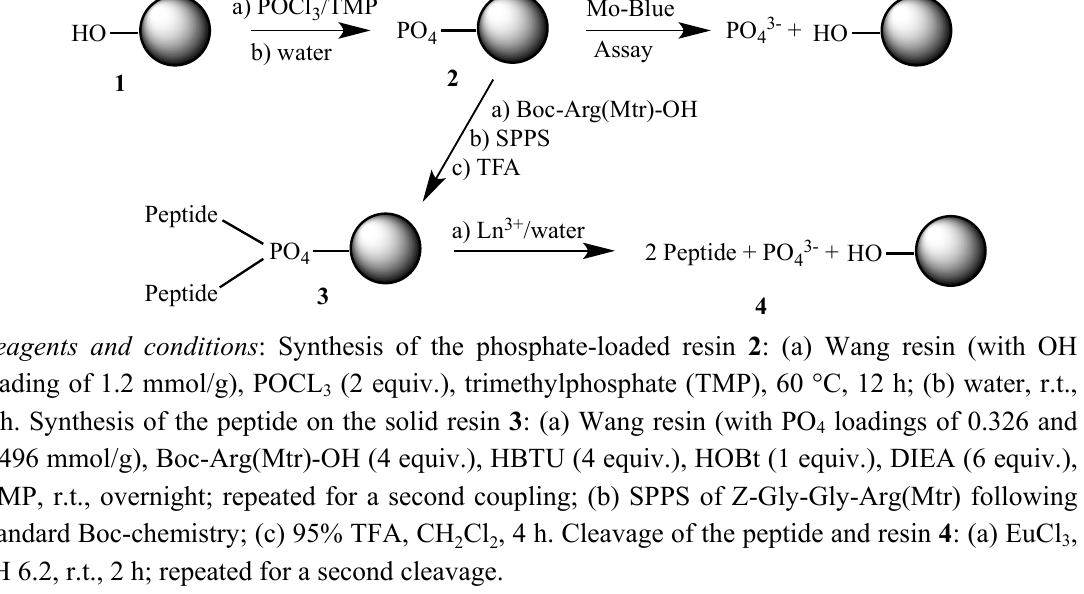
PO as a phosphate 2 4